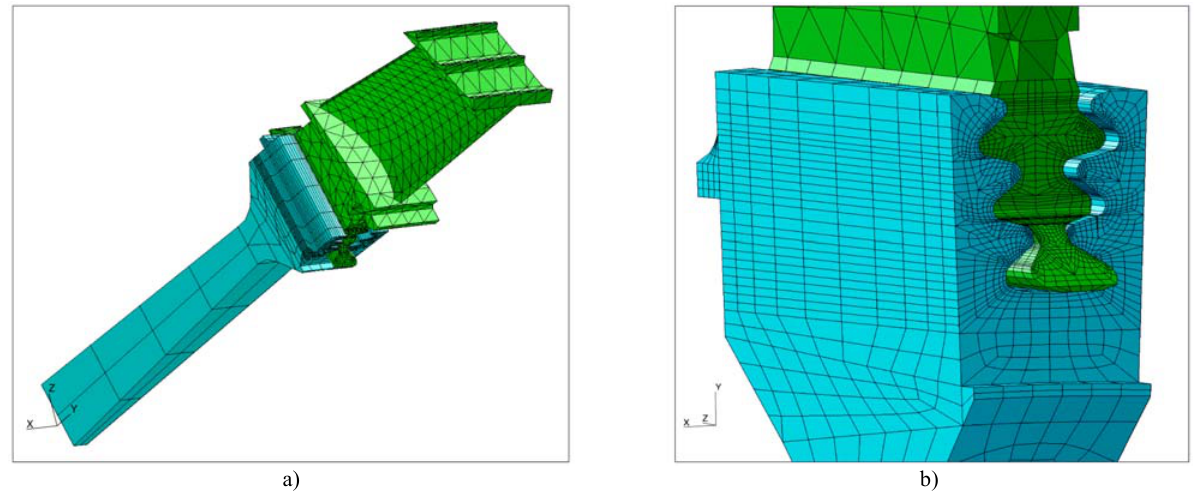
Fig 5 . Finite element model of the turbine segment (a) and mesh in the vicinity of fir-tree slots (disc-blade connection) (b)